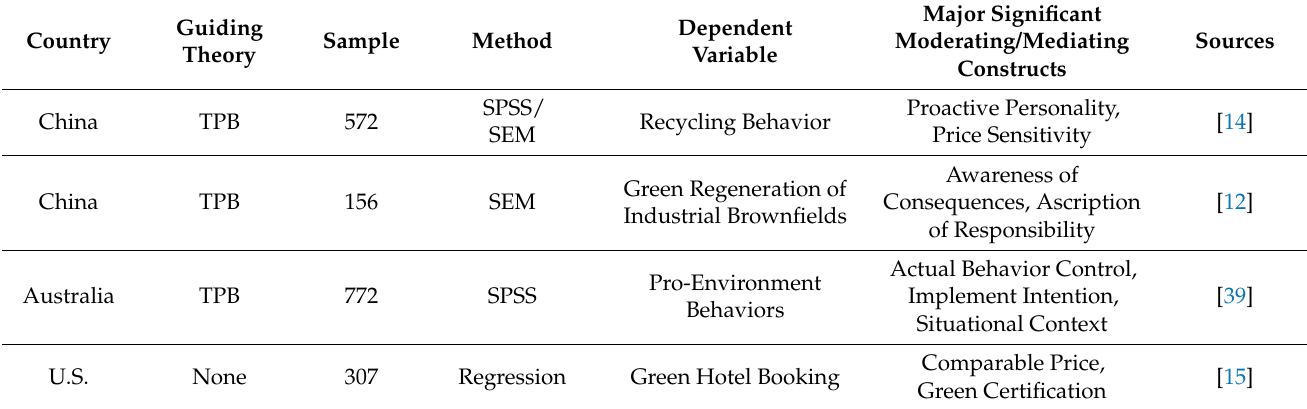
Table 1. Green Intention, Behaviors, and Intention–Behavior